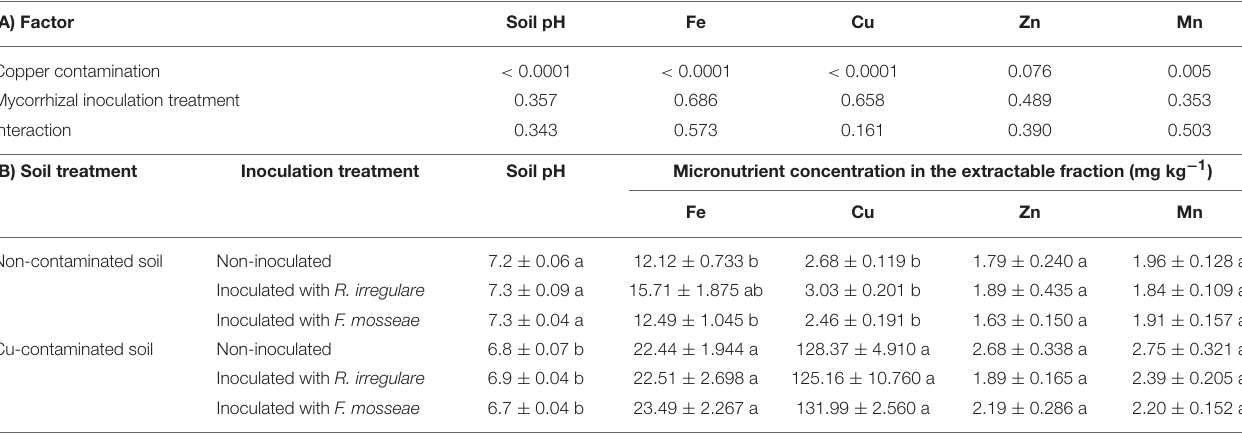
TABLE 2 | (A) P -values of the two-way ANOVA test for the effects of the factors “Copper contamination” and “Mycorrhizal inoculation treatment” and their interaction; (B) soil pH and micronutrient concentration in extractable fraction of the soil after three months growth of Touriga Nacional grapevine variety plants grafted onto 1103P rootstock inoculated or not with R. irregulare or F. mosseae .